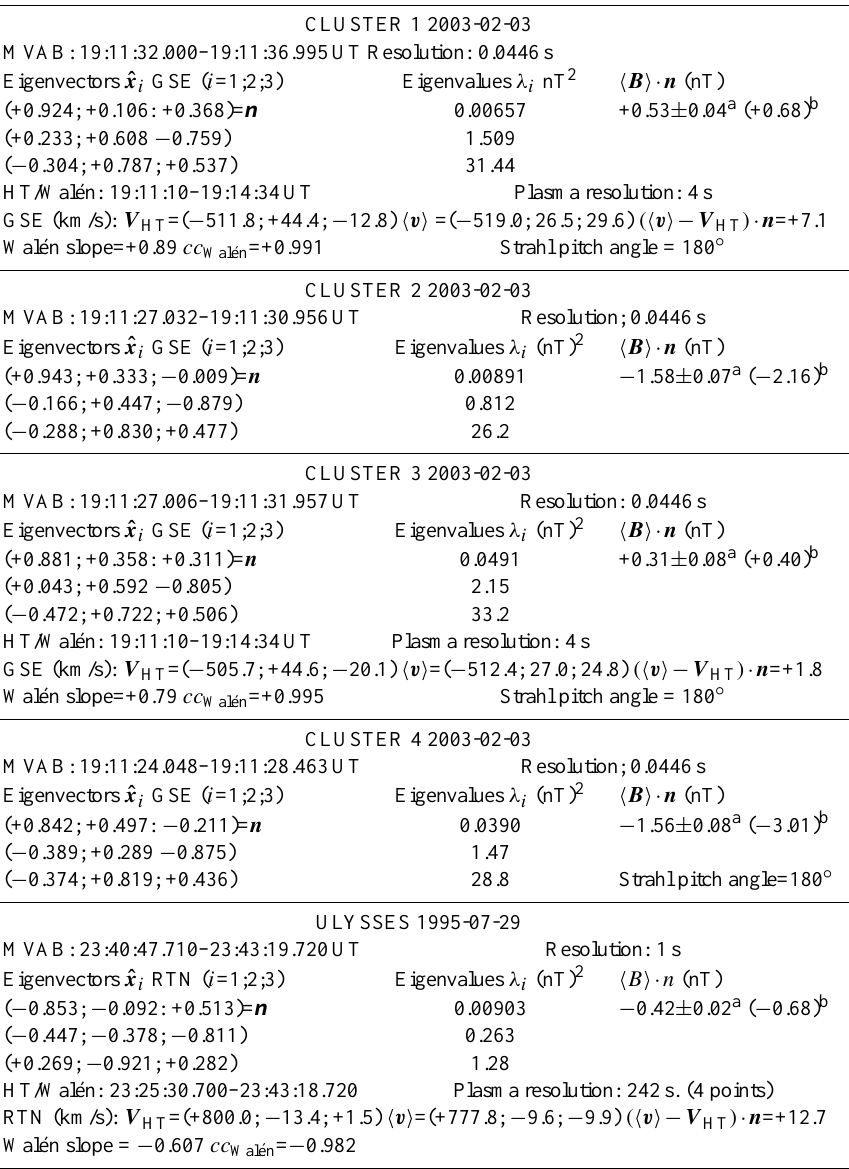
Table 1. Results from MVAB and HT/Wal´en analysis of Cluster and Ulysses